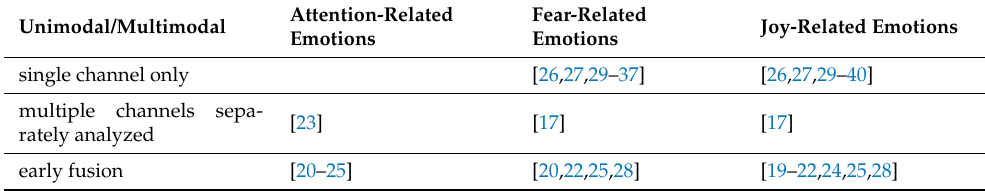
Table 11. Analysis of modalities versus identified groups of emotions.